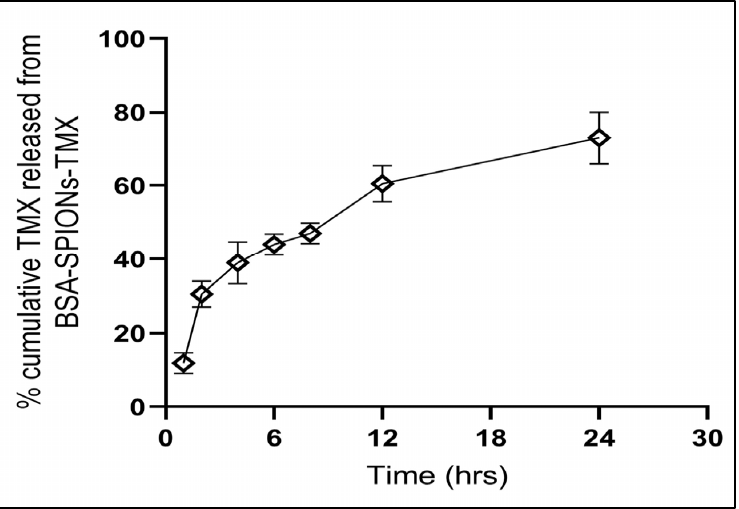
Figure 7. Percentage cumulative TMX released from BSA-SPIONs-TMX within 24 h. Data represent mean ± SD (n = 3). mean ± SD ( n =